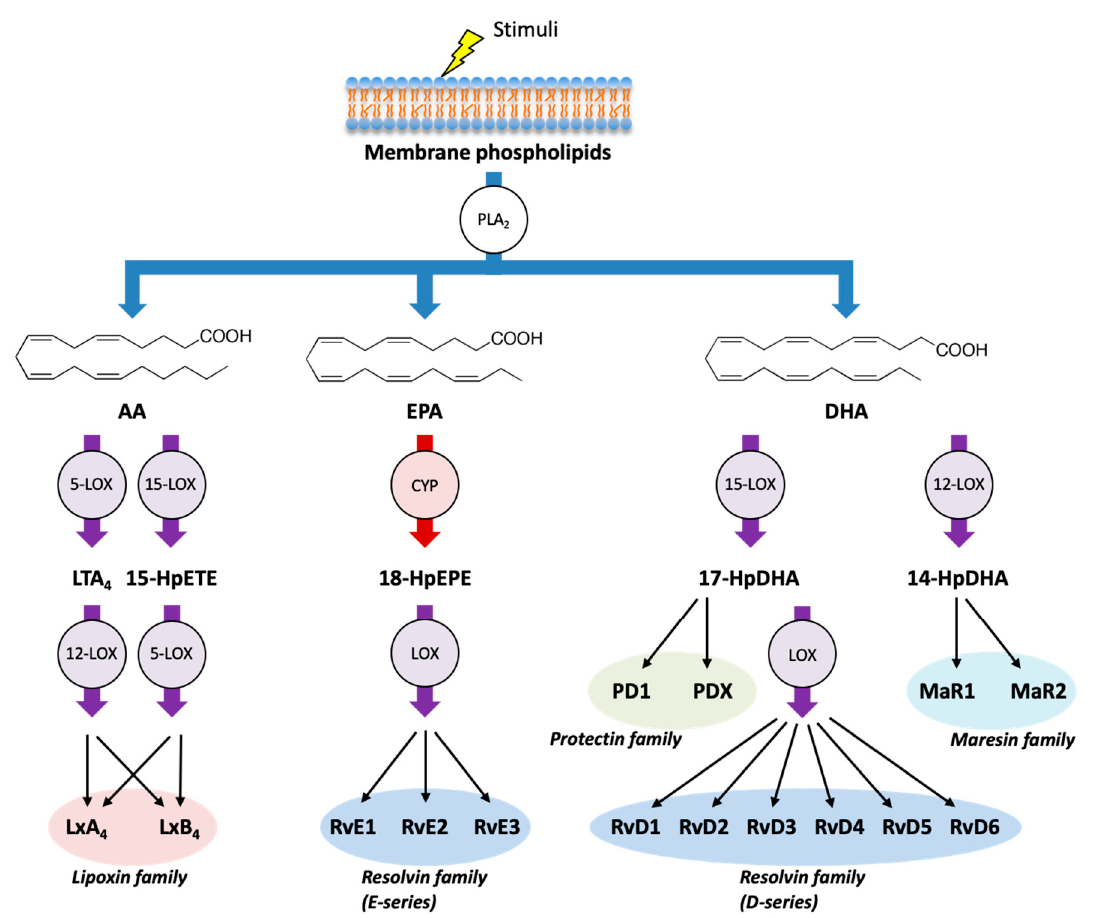
Figure 2. Biosynthetic pathways of specialized pro-resolving mediators (SPMs).In addition to AA, LOX pathway (purple) and CYP pathway (red) can metabolize the omega-3 PUFAs eicosapentaenoic acid (EPA) and docosahexaenoic acid (DHA) into various SPMs, which act as endogenous immunoresolvents upon stimulation. Lipoxins (LxA 4 and LxB 4 ) are formed from AA, E-series of resolvins (RvE1, RvE2, and RvE3) are formed from EPA, and D-series of resolvins (RvD1, RvD2, RvD3, RvD4, RvD5, and RvD6), protectins (PD1 and PDX), and maresins (MaR1 and MaR2) are formed from DHA. HpEPE: hydroperoxyeicosapentaenoic acid; HpDHA: hydroperoxydocosahexaenoic acid.